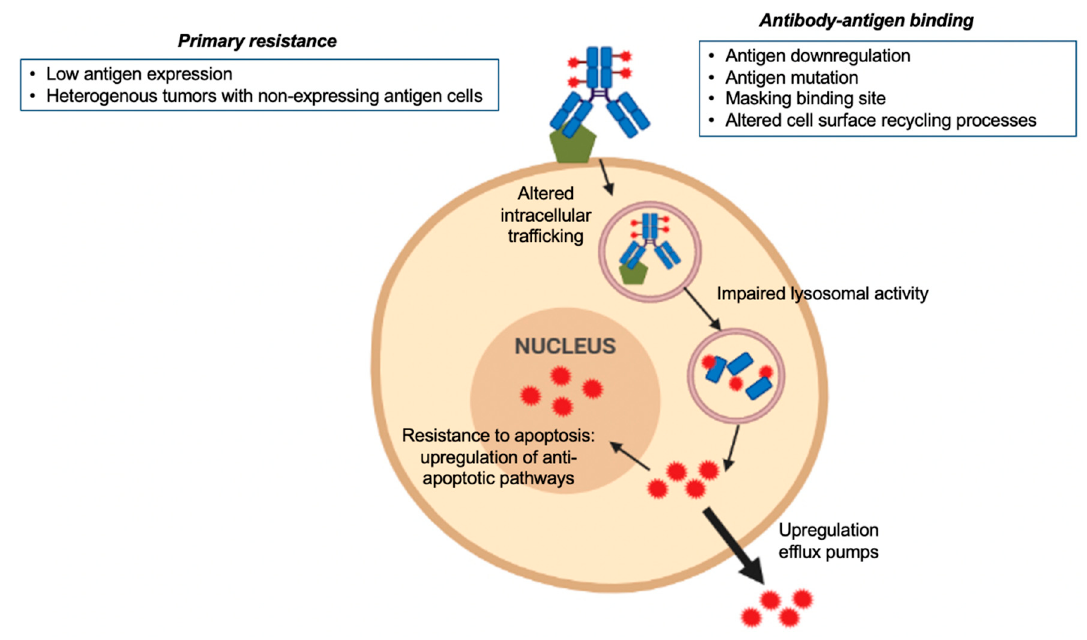
Figure 1. Mechanisms of resistance to antibody-drug conjugates (ADCs).